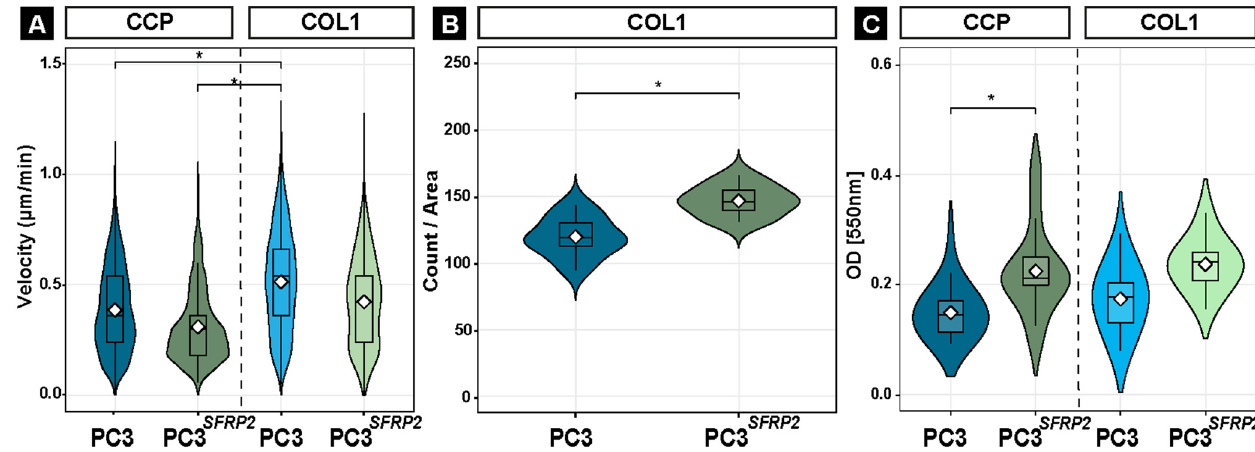
Figure 6. SFRP2 overexpression increases the osteotropic-like properties of PC3 cells on the COL1 surface. COL1-coating increases the random migration velocity of PC3 cells significantly, whereas overexpression of SFRP2 did not lead to such a significant increase in motility ( A ). Cellular invasion through a COL1 matrix shows that SFRP2 overexpression significantly increases the invasion of the PC3 cells ( B ). Cell attachment assay shows an increase in attachment with SFRP2 overexpression in PC3 cells cultured on both surfaces yet increase on COL1 is not significant. ( C ). Significance level: * equals p ≤ 0.05.